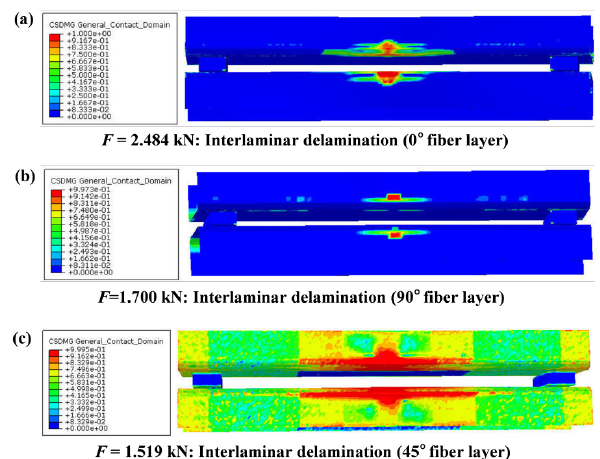
Figure 12: Initial interlaminar delamination failure area distribution of double-channel CARALL beams: (a) SHCXL-A: 0 ∘ fiber layer; (b) SHCXL-A: 90 ∘ fiber layer; and (c) SHCXL-B: 45 ∘ fiber